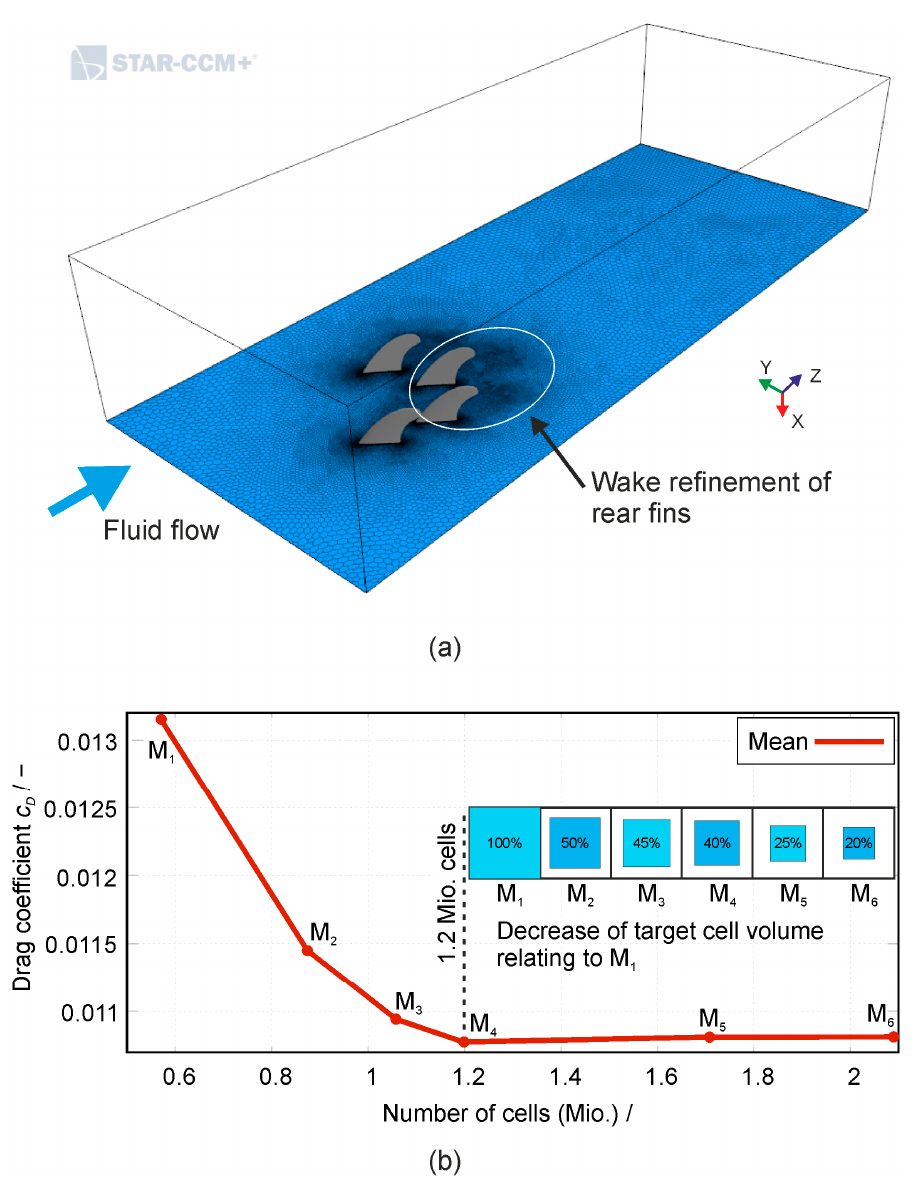
Figure 9. ( a ) Wake refinement of the fins shown at a mesh plane surface at the bottom wall. ( b ) Drag coefficient as a function of the number of control cells. Six different meshes with an increasing number of cells and a decreasing target cell volume were included in the mesh independence